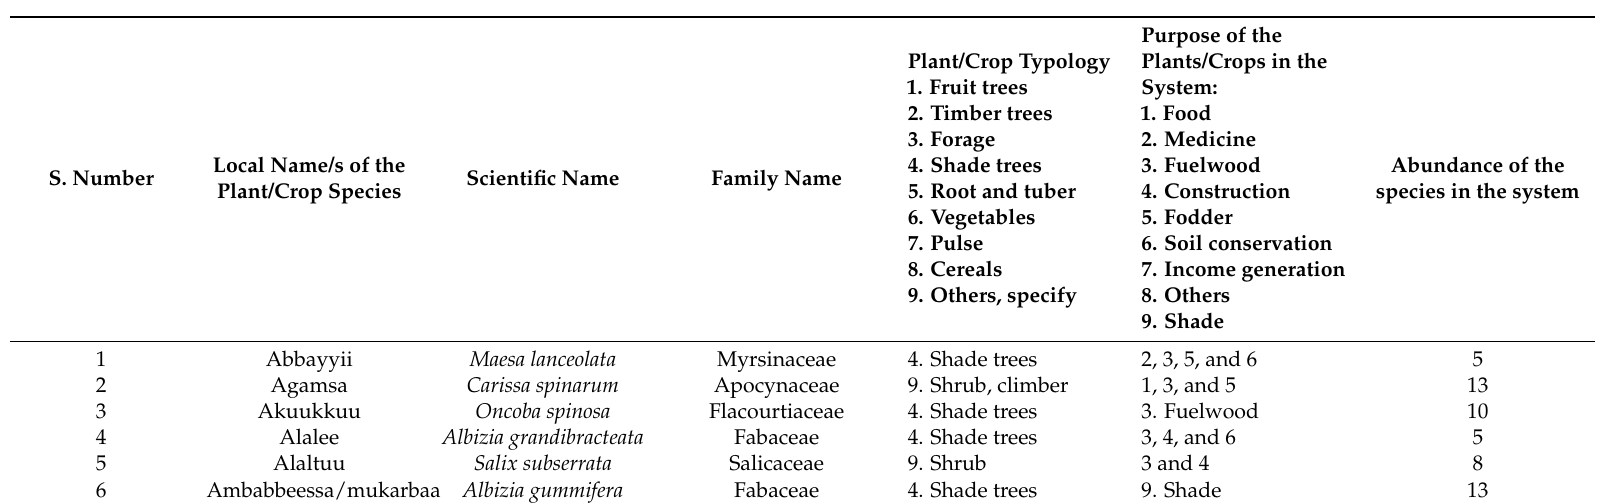
Table A4. Species Compositions of Semi-Forest Coffee Production